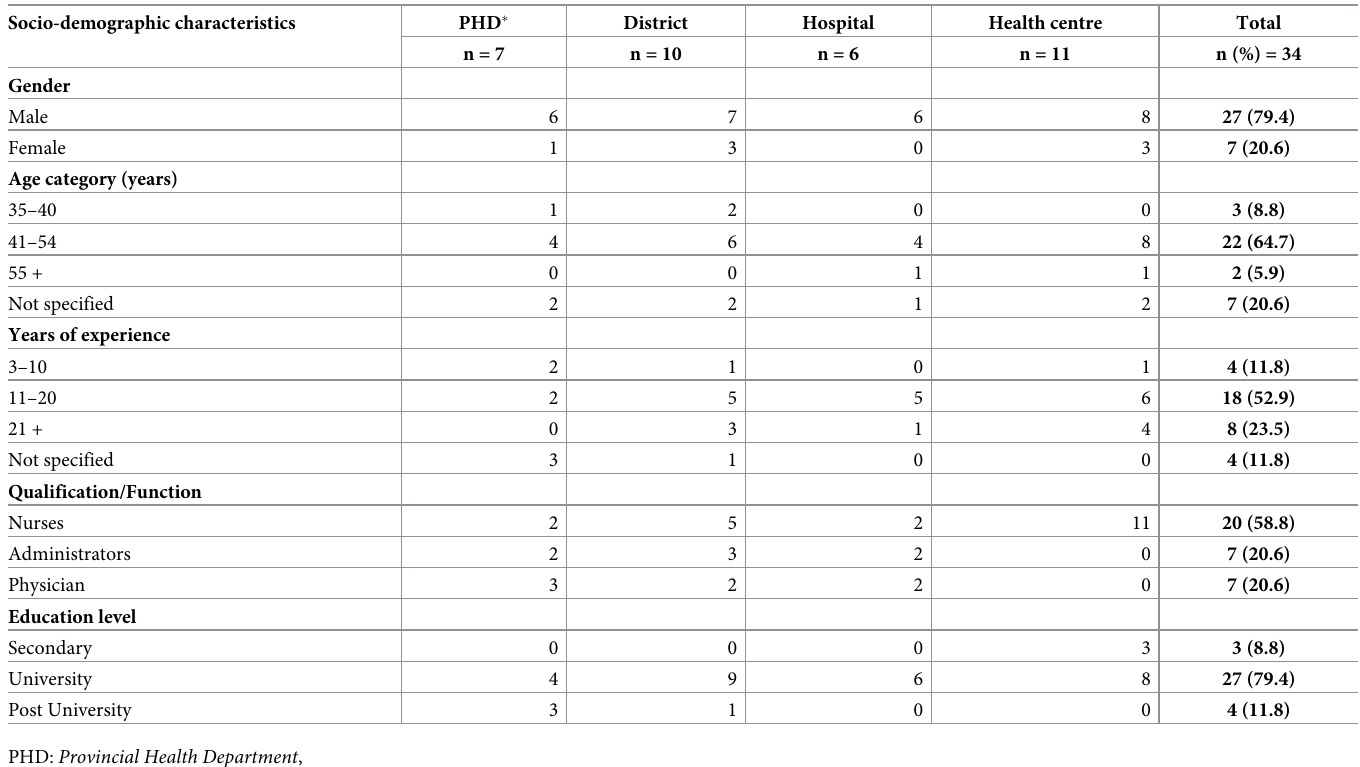
Table 1. Characteristics of the key